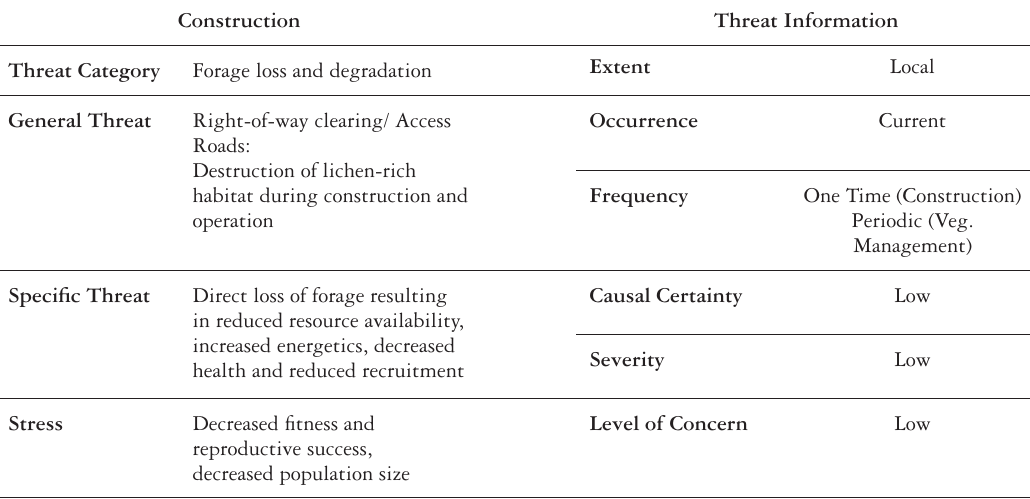
Table 1. Implications of threat categories for Site Selection and Environmental Assessment determined during Manitoba Hydro Boreal Woodland Caribou Workshop addressing destruction/degradation of boreal woodland caribou forage (lichens) located along transmission line